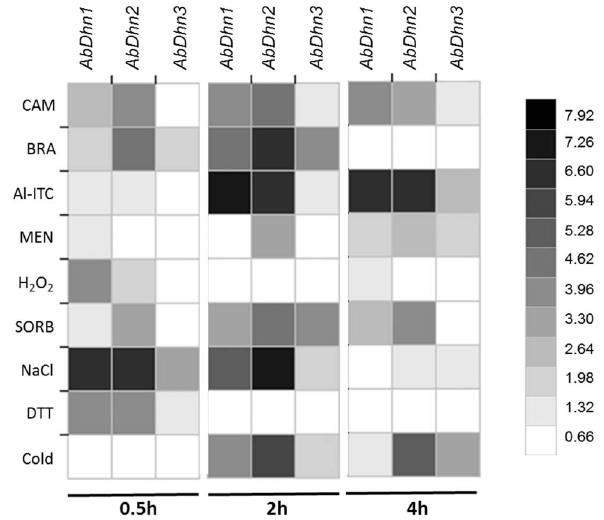
Figure 4. Expression levels of AbDhn1 , AbDhn2 and AdDhn3 sequences in A.brassicicola exposed to various stresses. First- strand cDNAs were prepared from RNA samples extracted from germinated conidia either exposed to 125 m M camalexin (CAM), 125 m M brassinin (BRA), 2.5 mM allyl-isothiocyanate (Al-ITC), 5 mM menadione (MEN), 5 mM hydrogen peroxide (H2O2), 1 M sorbitol (SORB), 350 mM sodium chloride (NACL), 20 mM dithiothreitol (DTT) or incubated at 4 u C (COLD) for the indicated times and used as template for real-time PCR. For each gene, expression induction is represented as a ratio (fold induction) of its relative expression (studied gene transcript abundance/ b -tubulin transcript abundance) in each inductive condition to its relative expression in the corresponding control. Each value is the mean of two independent experiments, each with three replicates. For easier visualization of the results, numerical data were transformed into colour-grid representations using JColorGrid software [45] in which the fold gene expression induction (Log 2 values) is represented by a grey scale (on the right). expression patterns were observed with the strain expressing AbDhn2-GFP, whereas GFP expression in the control strain resulted in diffuse green fluorescence ( Fig. S3 ). Based on previously published results on dehydrin-like proteins from A.